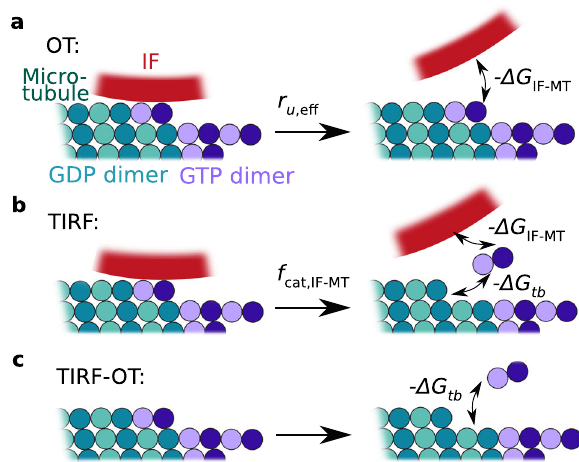
Fig. 6 Estimation of the binding energy of a single tubulin dimer by combining the OT and TIRF experiments. a From the OT experiments including the simulations, we determined the unbinding rate of microtubules and vimentin IFs r u ,eff and the released energy − Δ G IF-MT during unbinding. b In TIRF experiments, a tubulin dimer dissociates from the microtubule and the vimentin IF, so that the total energy − Δ G tb − Δ G IF-MT is released. We calculated the catastrophe frequency of a microtubule f cat,IF-MT in case a vimentin IF is bound to the microtubule. c We estimated the average binding energy Δ G tb of a tubulin dimer in the microtubule lattice before catastrophe by subtracting the released energies from ( b ), − Δ G tb − Δ G IF-MT , and by dividing the unbinding rate r u ,eff of microtubules and vimentin IFs by the catastrophe frequency f cat,IF-MT of microtubules bound to a vimentin IF as shown by Eq. (15) in the Supplementary